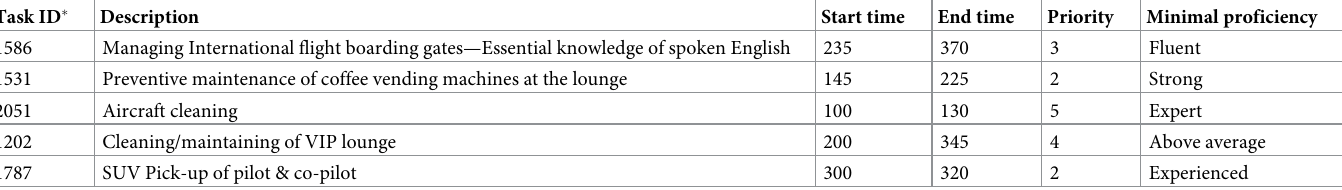
Table 1. Sample tasks with their